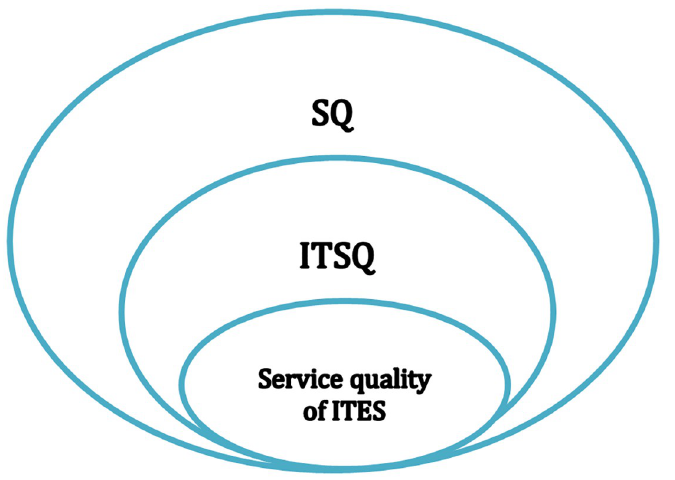
Fig 1. Hierarchy of service quality